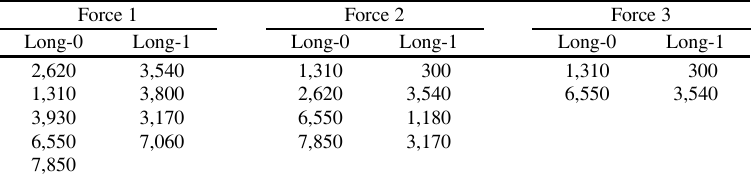
Table 10 Excitation frequencies (Hz) observed in FFT response of acceleration results